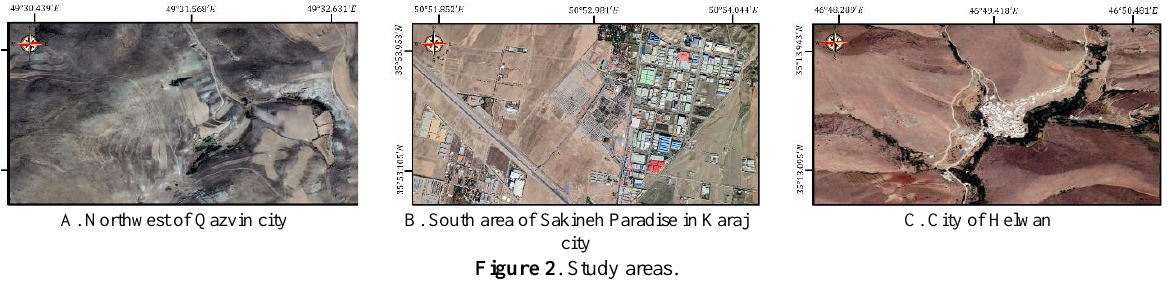
To begin with data analysis, a 3D model of low contrast images must be constructed. Thus, considering the high contrast of the images of the Qazvin and Karaj regions, a contrast reduction method was applied. Ultimately, using Halvan data with low image contrast, a 3D model was constructed. A 3D model was constructed using the proposed contrast-enhancement algorithm on the aforementioned images in the second stage. Figure 4 illustrates a sample of low-contrast, original and improved images are taken from a height of 90 m, together with their histogram. Figure 3 . Phantom 4 Pro UAV.